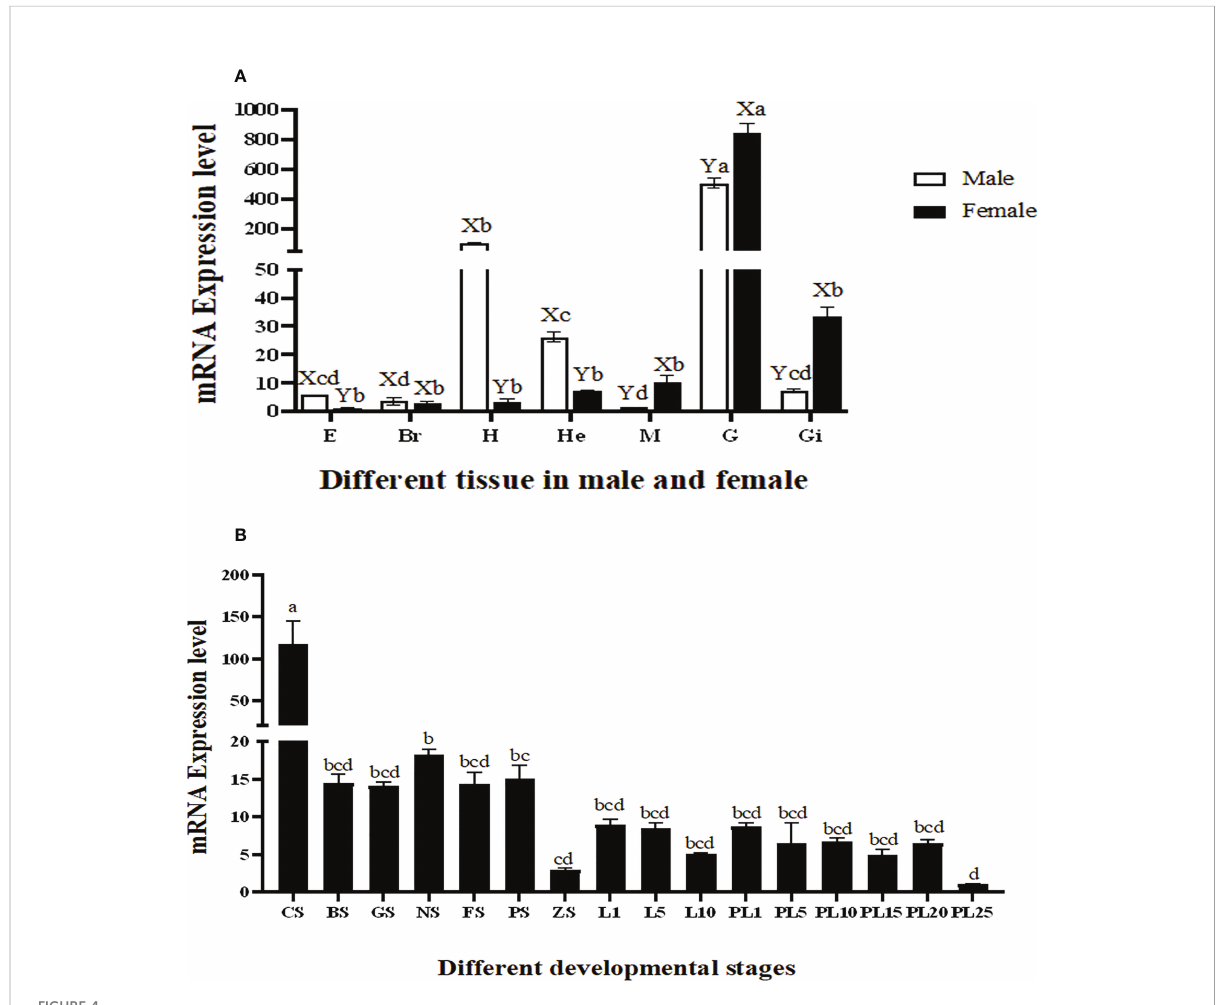
FIGURE 4 Measurement of the Mn-Plk1 expression in different mature tissues and developmental stages by qPCR. The amount of Mn-Plk1 mRNA was normalized to the EIF transcript level. Data are shown as mean ± SD (standard deviation) of tissues from three separate individuals. Lowercases (a-d) on the bars indicate expression differences among all tissues from both sex (ANOVA). Capital letters (X, Y) on the bars indicate the expression differences in the same tissue between male and female prawns (independent sample T-test). (A) Mn-Plk1 expression in different mature tissues. (B) Mn-Plk1 expression in different developmental stages. E, eyestalk; Br, brain; H, heart; He, hepatopancreas; M, muscle; G, gonad; Gi, gill; CS, cleavage stage; BS, blastula stage, GS, gastrula stage; NS, nauplius stage; FS, posterior nauplius stage; PS, protozoea stage; GS, zoea stage; L, larval developmental stage; PL, post-larval developmental